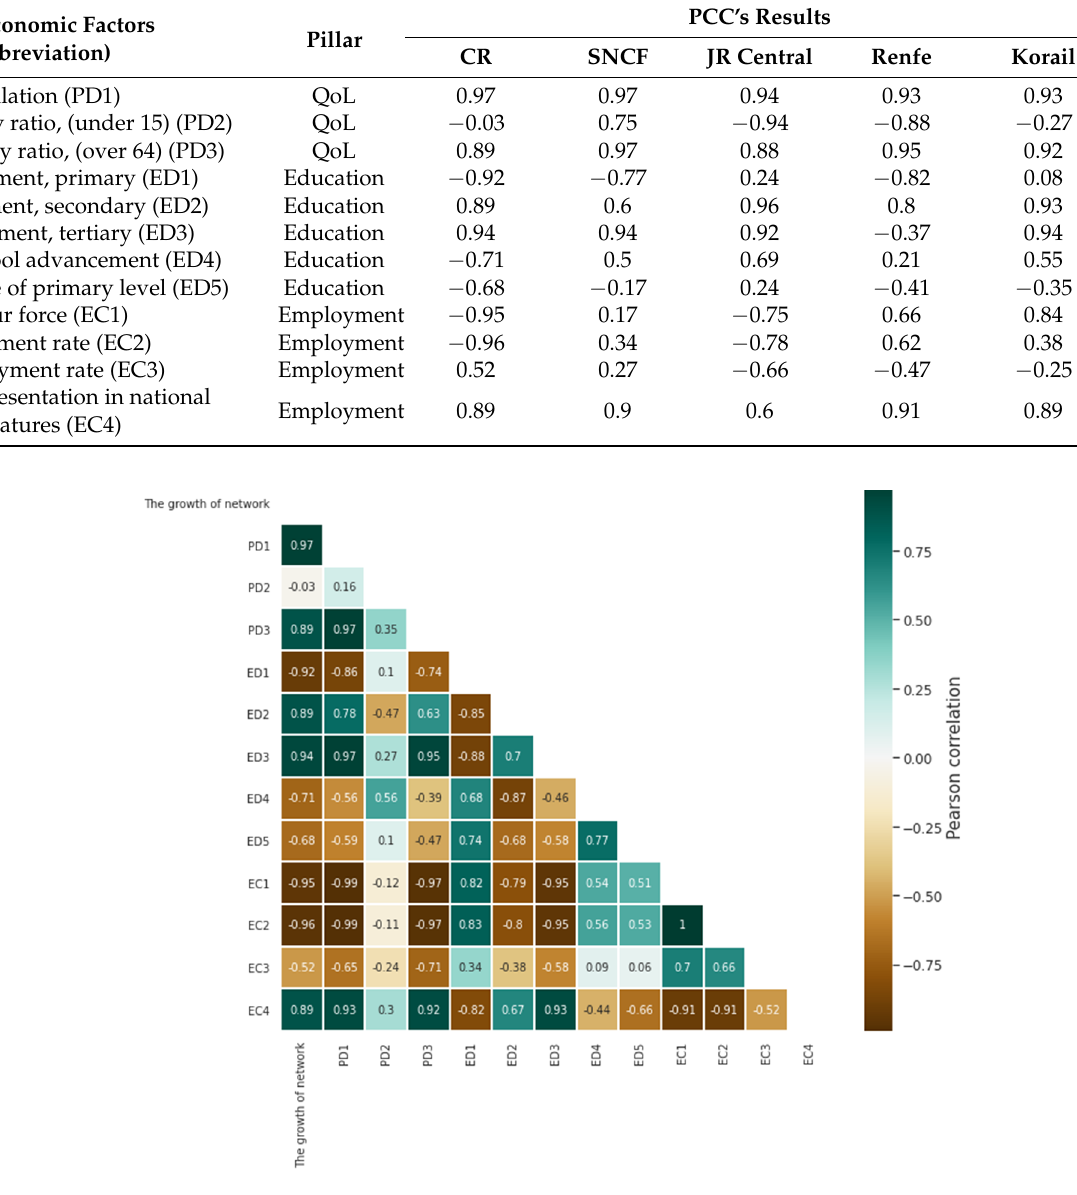
Figure 3. The PCC’s outcome of CR network.